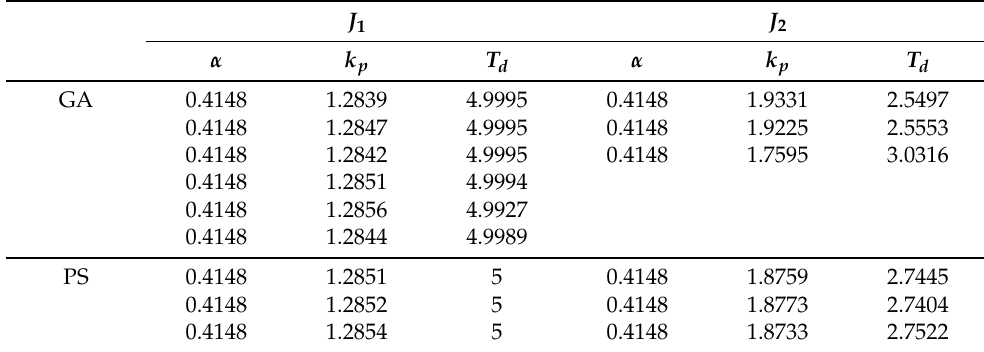
Table 2. Optimization results from applying particle swarm and genetic algorithms to minimization criteria (9) and (10) with constraints (11).